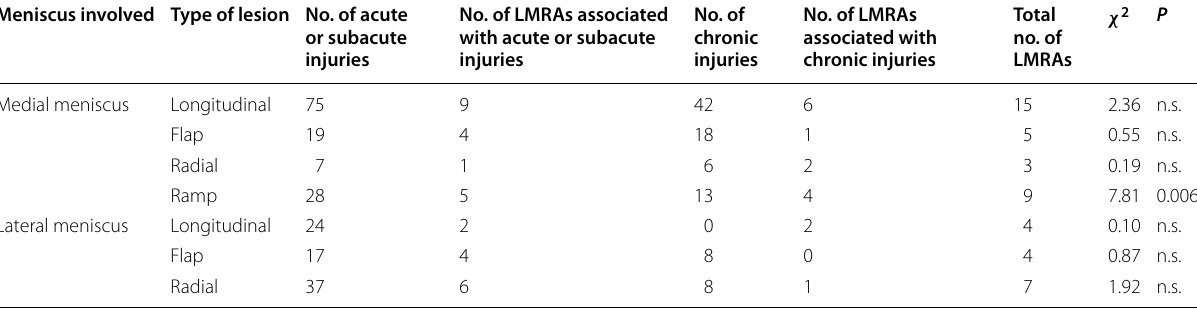
Table 7 Associations of lateral meniscal root avulsion with concomitant meniscal lesions detected at the time of ACL reconstruction Meniscus involved Type of lesion No. of acute or subacute